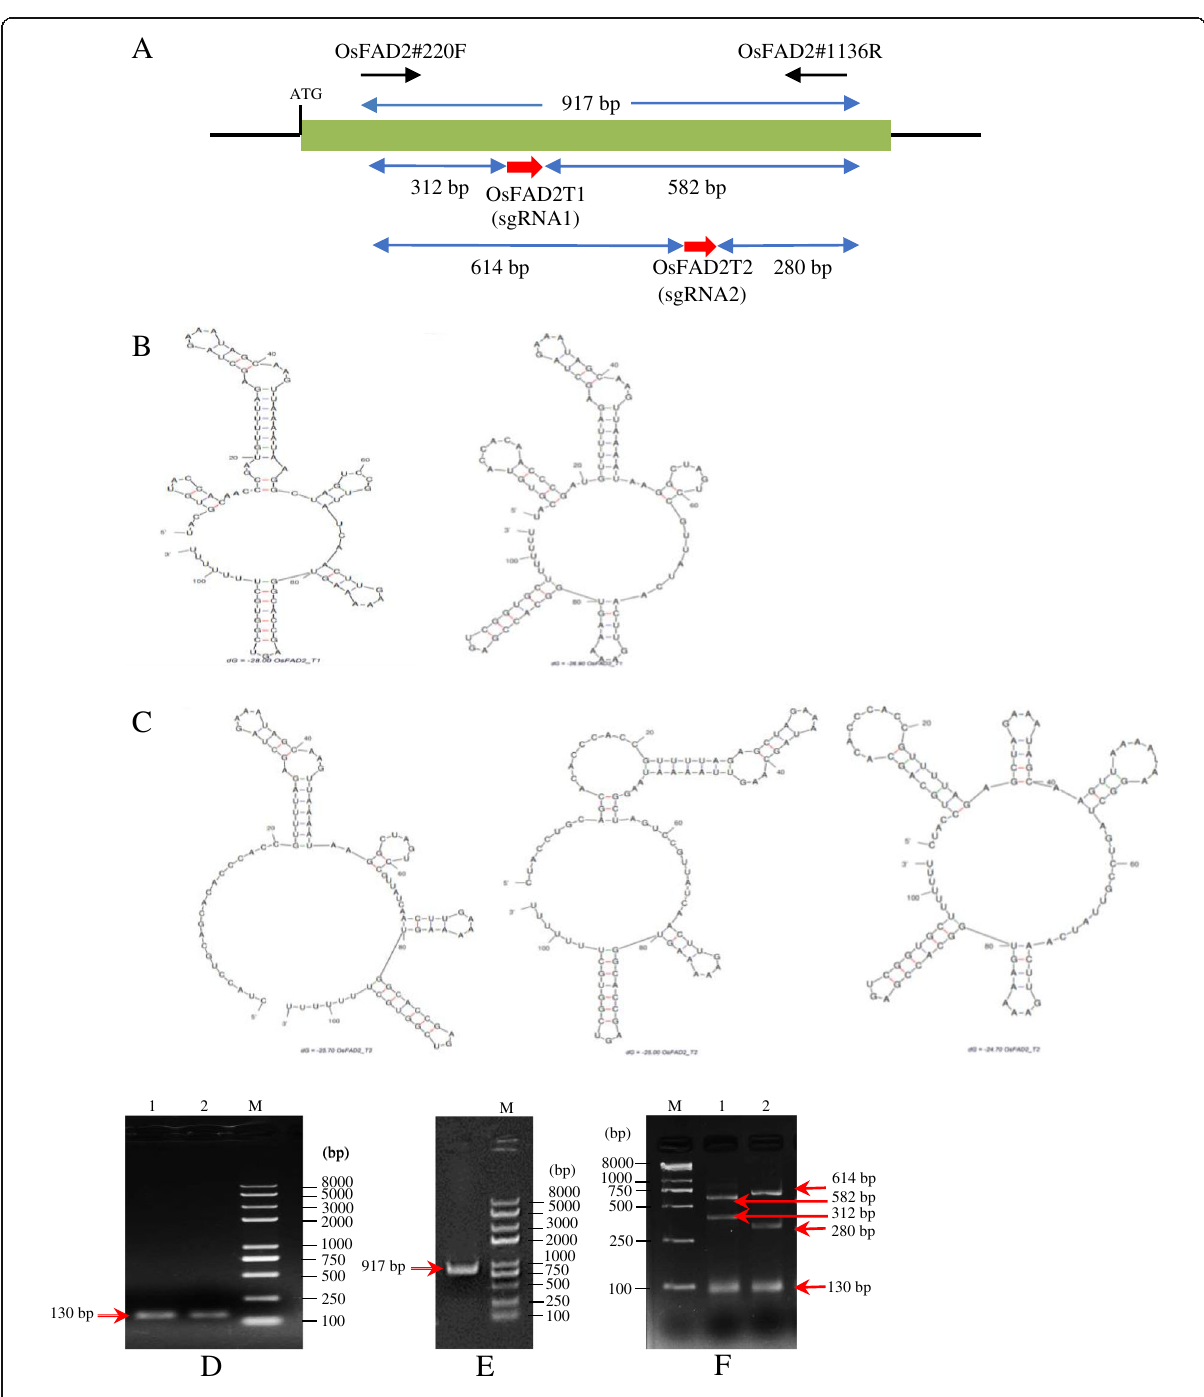
Fig. 2 A Schematic of OsFAD2-1 gene loci. Predicted secondary structures for ( B ) sgRNA1 and ( C ) sgRNA2. PCR amplification and validation of sgRNAs via in vitro Cas9 cleavage assay; D PCR product from amplification of sgRNAs template at ~ 130 bp (lane 1: sgRNA1, lane 2: sgRNA2) for in vitro transcription, E PCR amplification of rice target DNA region (OsFAD2T1T2) at ~ 917 bp, and ( F ) analysis of cleavage products for sgRNA1 at 312 bp and 582 bp (lane 1) and sgRNA2 at 614 bp and 280 bp (lane 2). Band size at ~ 130 bp in ( F ) at lanes 1 and 2 are the residue of sgRNA template. Red arrows indicate the band size at the expected molecular weight. Lane M is Trans2K® Plus II DNA Marker (TransGen Biotech,